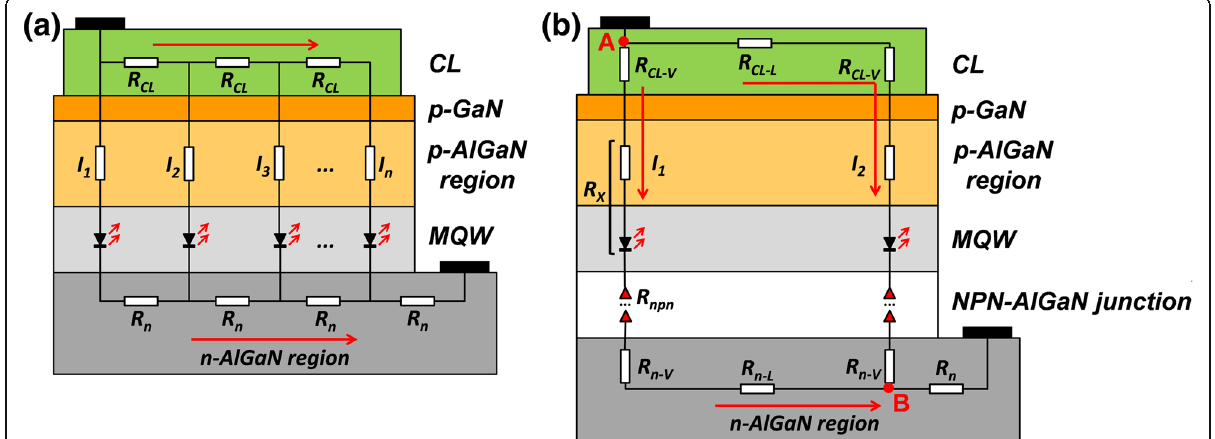
Fig. 2 a DUV LEDs with lateral current-injection scheme equivalent circuit ( I 1 > I 2 > I 3 > …… > I n ). b NPN-AlGaN-structured DUV LED simplified equivalent circuit and current paths I 1 and I 2 are